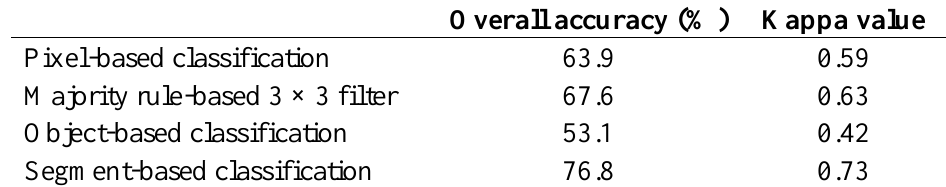
Table 5. Accuracy assessments by classification